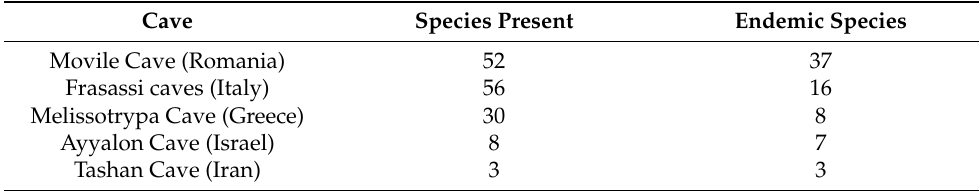
Table 1. The number of invertebrate species encountered in sulfidic cave ecosystems analogous to Movile Cave. All endemic species encountered in these sulfidic ecosystems are restricted to caves. Cave Species Present Endemic Species Movile Cave (Romania) 52 37 Frasassi caves (Italy) 56 16 Melissotrypa Cave (Greece) 30 8 Ayyalon Cave (Israel) 8 7 Tashan Cave (Iran) 3